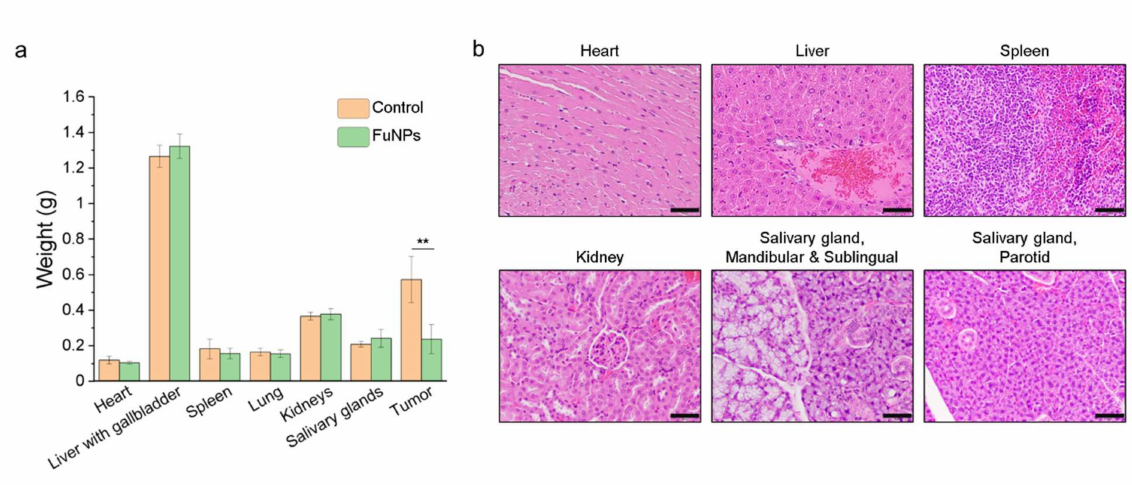
Figure 7. Safety assessments of FuNPs. ( a ) The organs and tumors weight of the mice treated with saline (control) and FuNPs; ( b ) H&E stain for the pathological analysis of the mice treated with FuNPs. Scale bar = 50 µ m. The experiments were performed with 4 biological independent animals. One-way ANOVA was performed in Figure 7a to evaluate the statistical difference between the tumor weight between control and FuNP-treated mice; ** p <